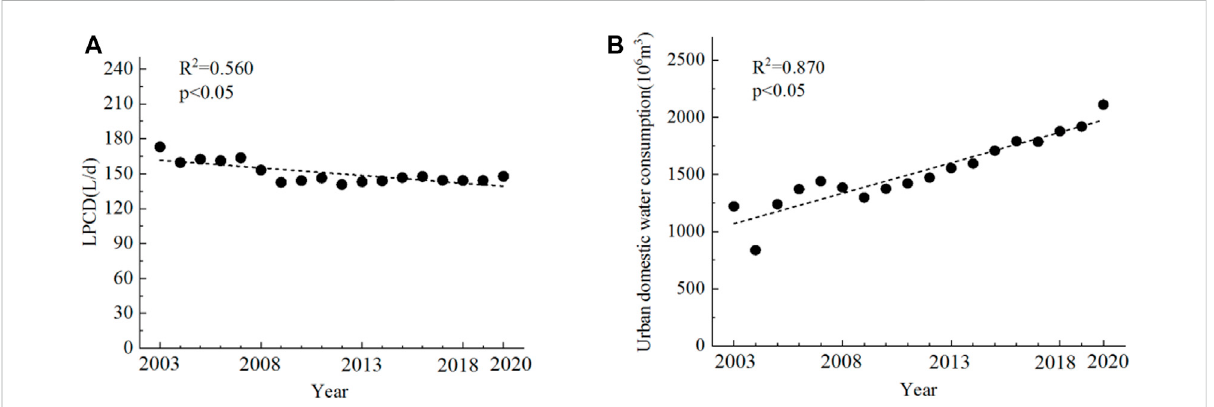
FIGURE 2 Pro fi les ofurban domesticwater consumptioninNorthwest China. Note: (A,B) represent liters ofwater consumption per capitaper day(LPCD) and total water consumption of urban residents, respectively.